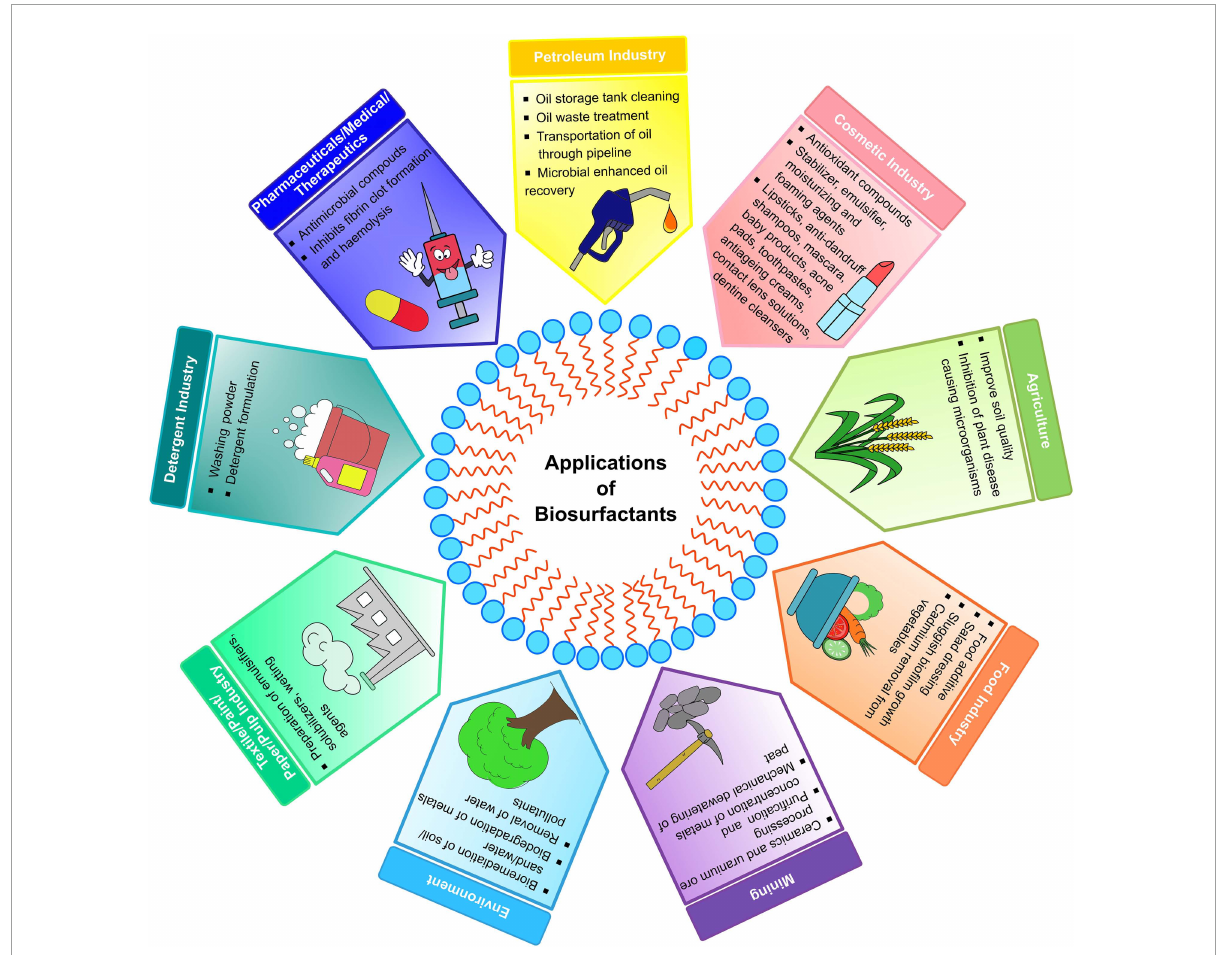
FIGURE7 An overview of potential applications of biosurfactants in different